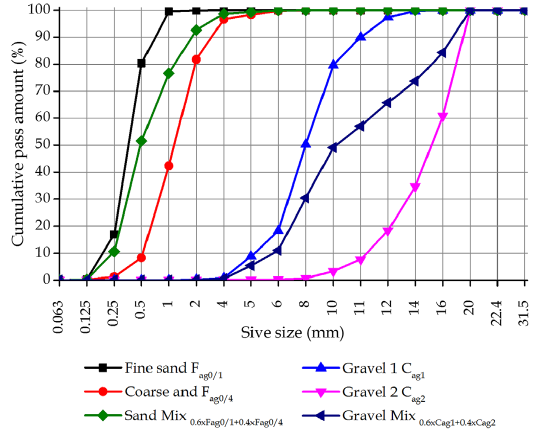
Figure 1. Particle size distribution of